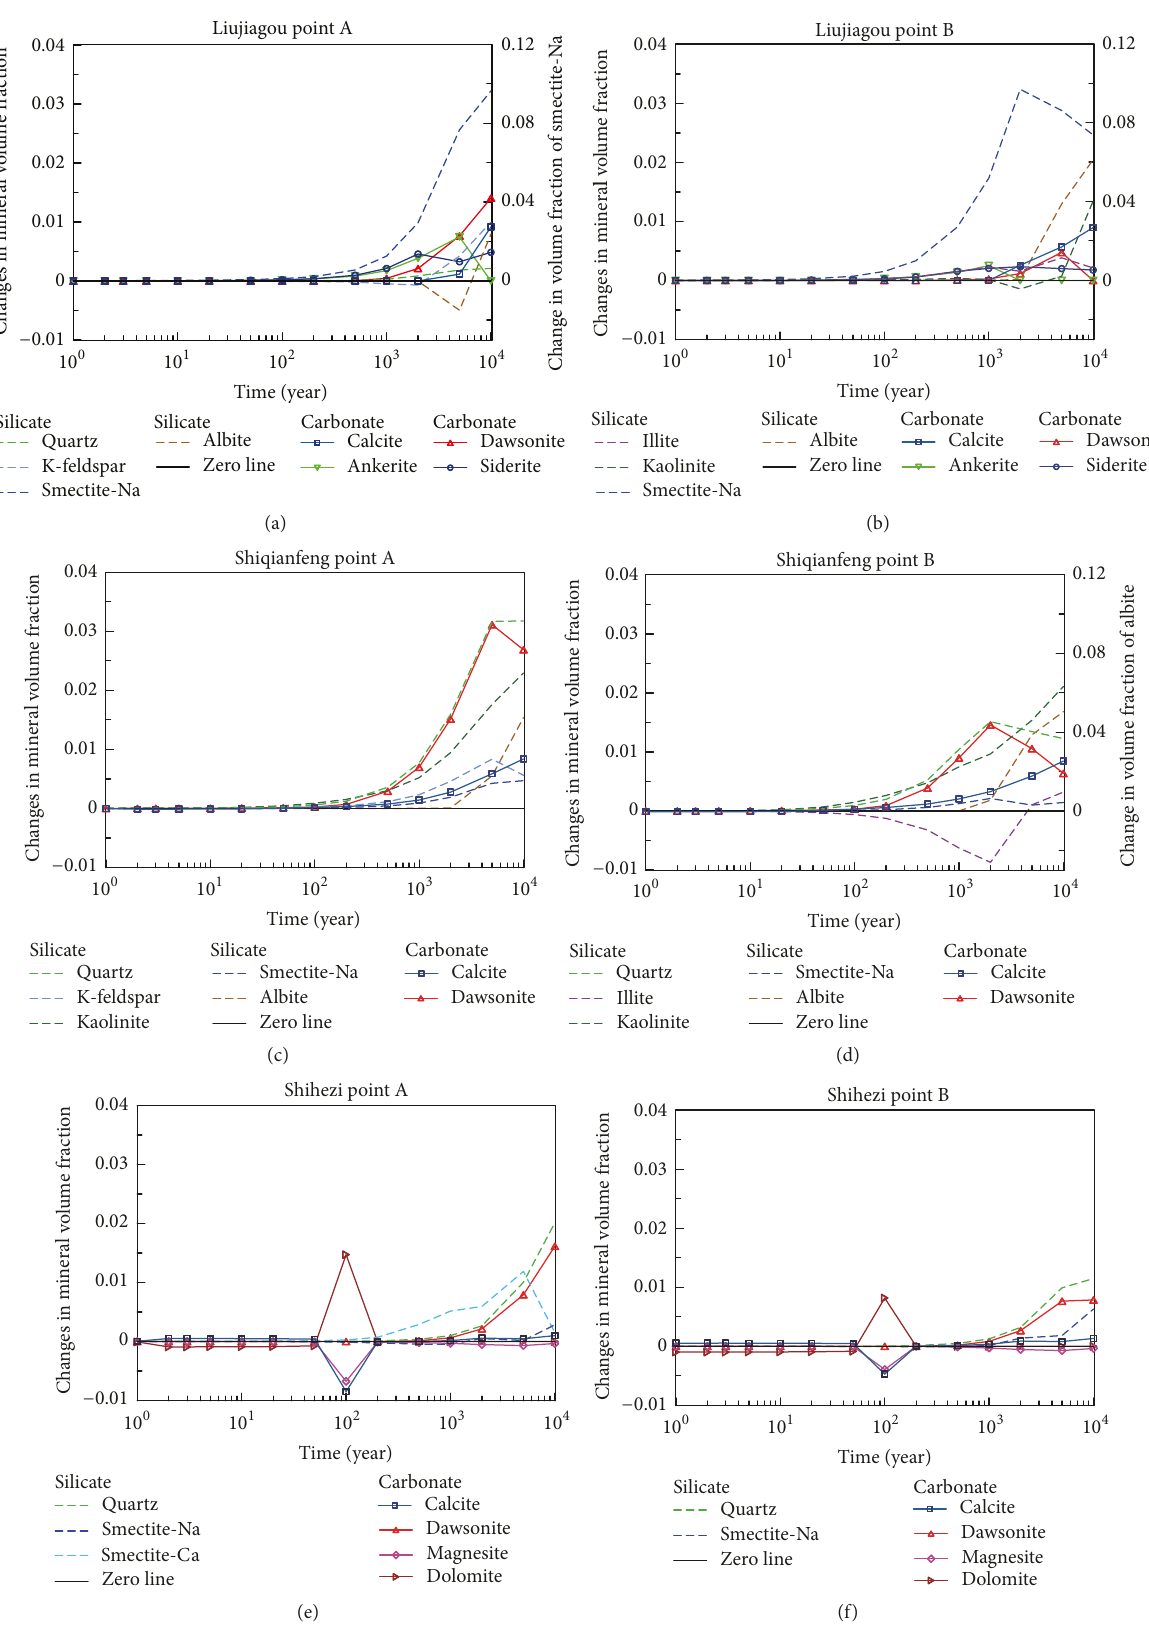
Figure 9: The evolution of mineral abundance changes at points A and B for the Liujiagou formation (a, b), Shiqianfeng formation (c, d), and Shihezi formation (e, f) over